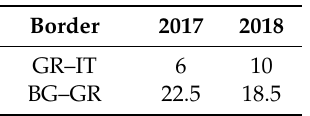
Figure 3. Energy balance between Greece and interconnected countries. Table 3. The estimated social welfare gains from further extending Day Ahead (DA) market coupling in Greece and Italian / Bulgarian